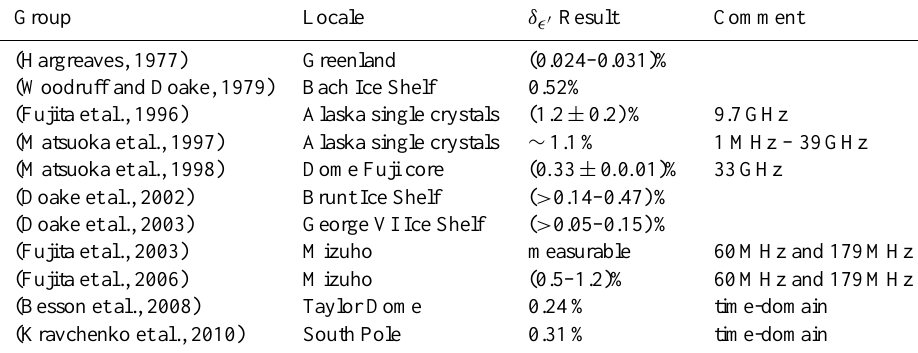
Table 1. Summary of recent birefringence measurements. Presented values of δ (cid:15) 0 give the asymmetry between the “ordinary” vs. “extraor- dinary” measured real permittivities, corresponding to “fast” vs. “slow” in-ice wavespeeds. Fractional values (in percent) are normalized to the average ice dielectric permittivity at radio frequencies.